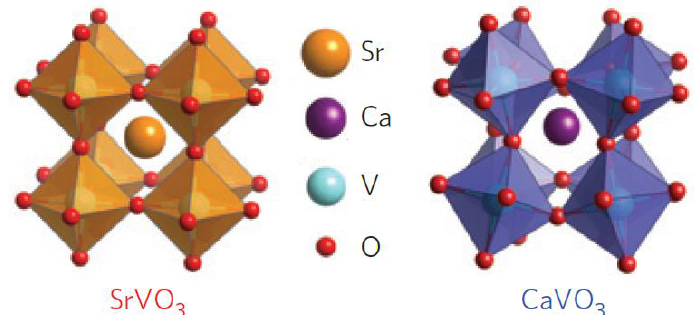
Figure 2. Crystal structure of SrVO 3 and CaVO 3 . Reprinted (adapted) with permission from Zhang,